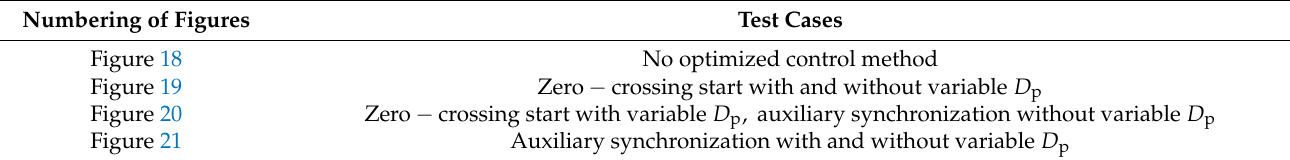
Auxiliary synchronization with and without variable D p